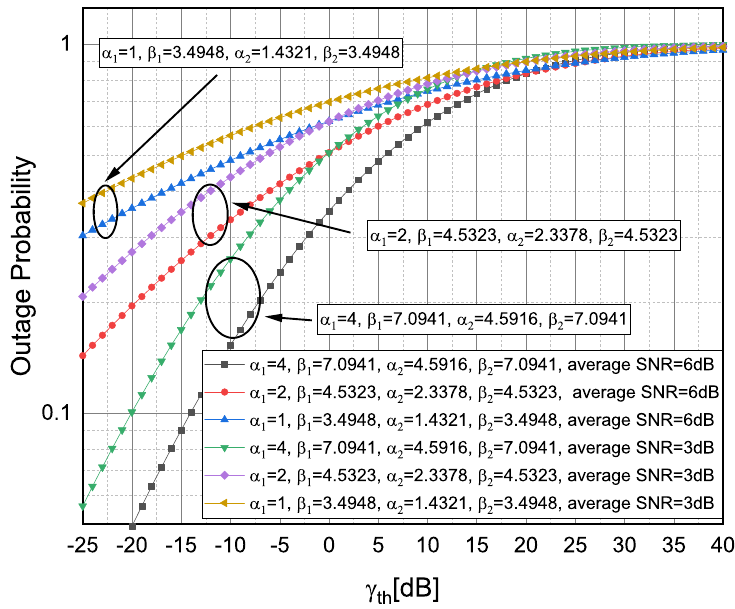
Figure 2. Outage probability versus γ th observed for different TI fading severity conditions.